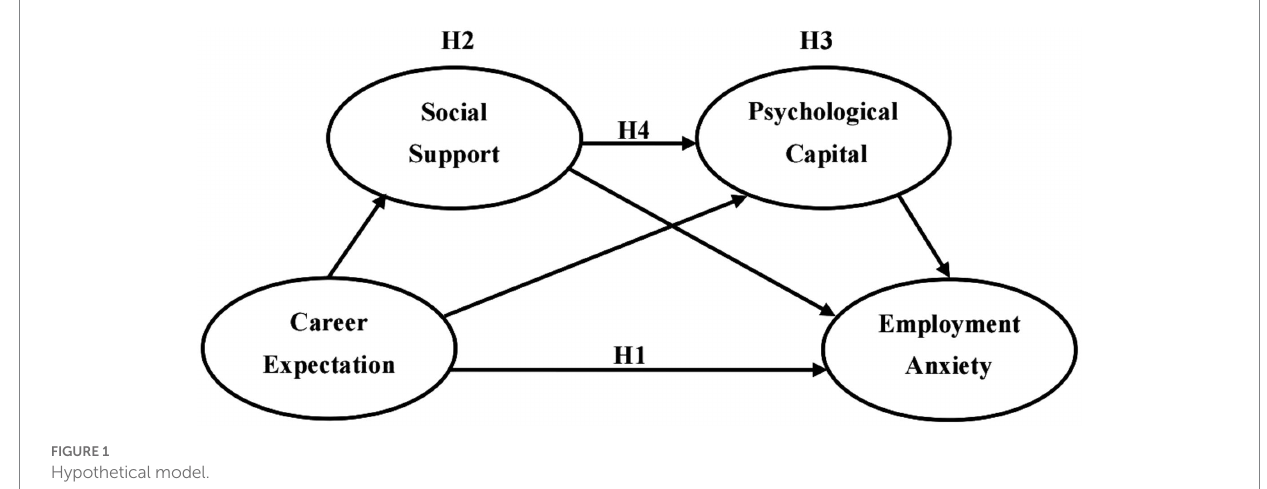
FIGURE 1 Hypothetical